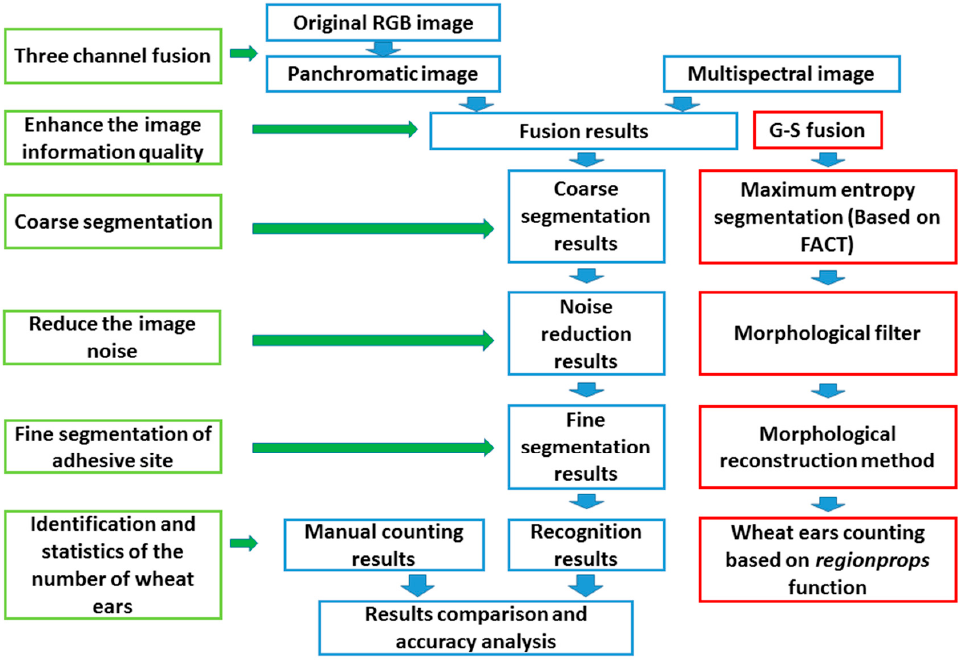
Figure 3. Flow chart of recognition and counting method of wheat ear at filling stage. 3.1. Fusion of Panchromatic Images and Multispectral Images Based on Gram-Schmidt Spectral Sharpening